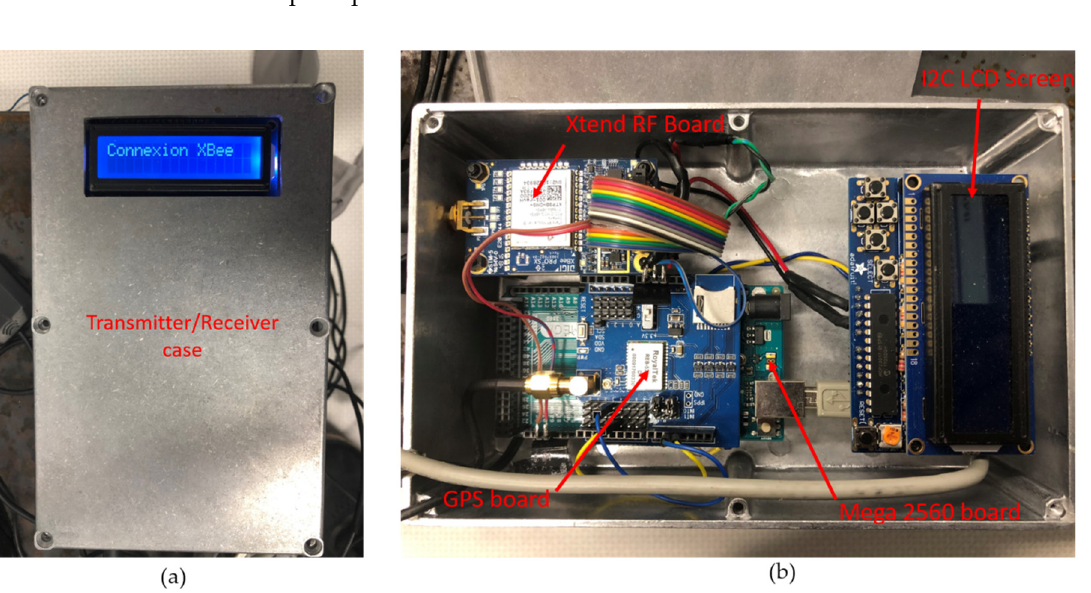
Figure 16. In ( a ) the Receiver/Transceiver case; ( b ) the inside of the Receiver/Transceiver.